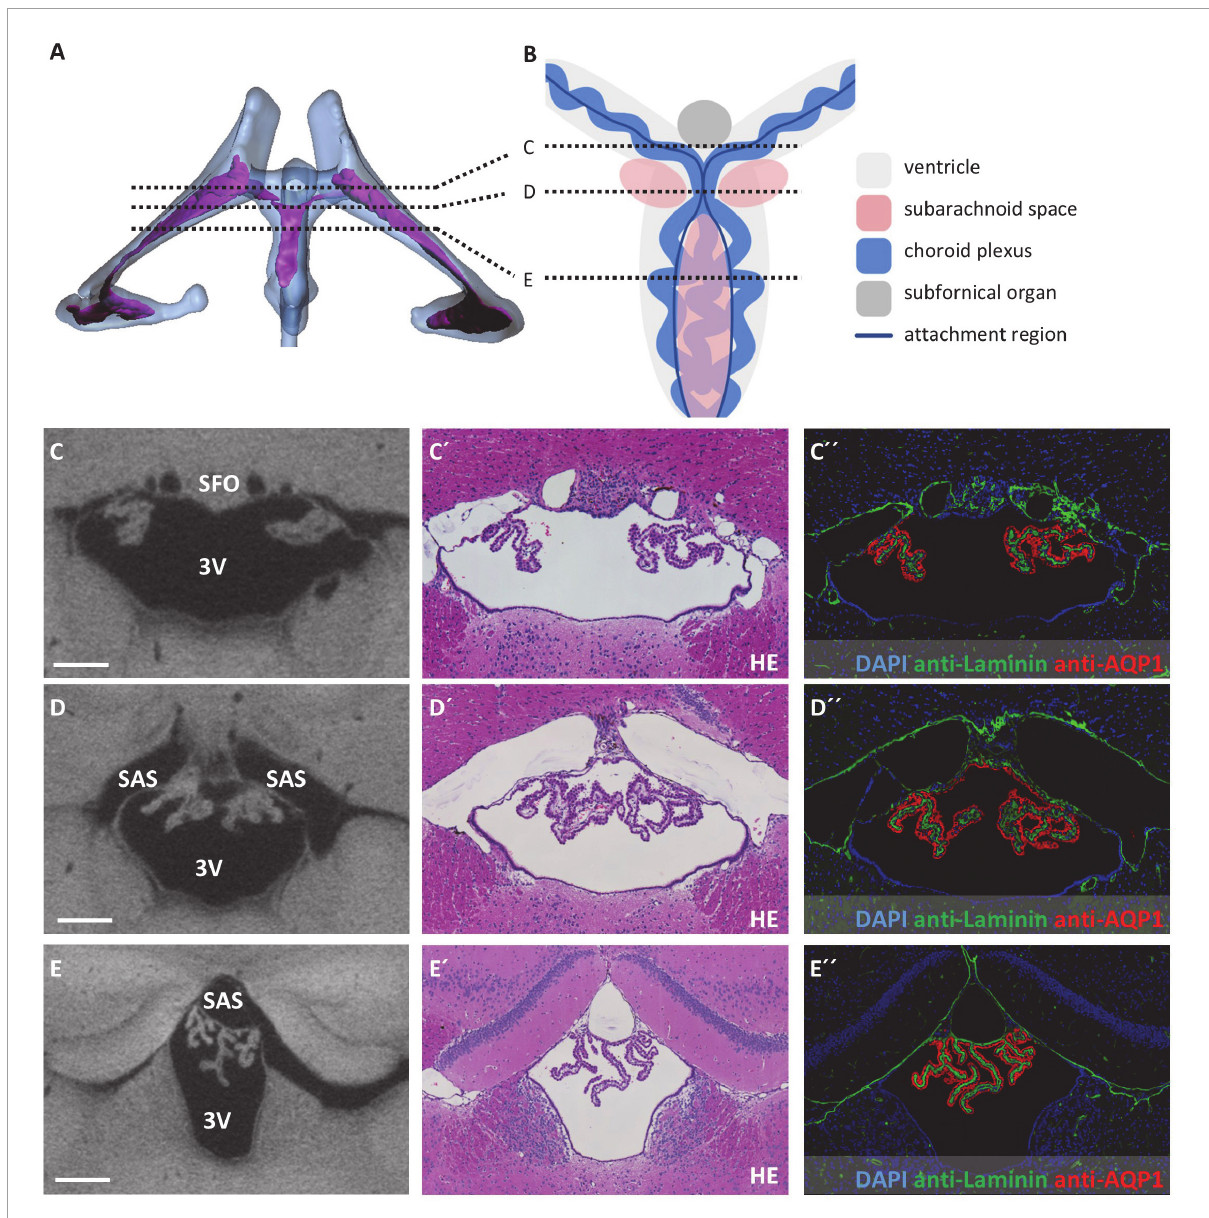
FIGURE4 Attachment regions of the choroid plexus in the third ventricle. (A) Illustration of sectional planes in three-dimensional reconstruction of the lateral and third ventricle (blue) and the choroid plexus (purple) in a dorsal view. (B) Schematic drawing of the third ventricle in dorsal view with choroid plexus, subfornical organ, subarachnoid space, and sectional planes of (C–E) . Created with BioRender.com (C–E) On the left, sectional planes from micro-computed tomography scan; in the middle, hematoxylin-eosin staining; and on the right, immunofluorescence double labeling with anti-laminin (green), anti-aquaporin1 (AQP1, red), and nuclear staining with 4 (cid:48) ,6-diamidino-2-phenylindole (DAPI, blue). (C–C”) Coronal section at the level of the subfornical organ occipital to the interventricular foramen; (D–D”) coronal section occipital to the subfornical organ with median attachment site of the choroid plexus and lateral cavities of subarachnoid space; (E–E”) coronal section at the level of the rostral hippocampus, the choroid plexus is attached to the roof of the third ventricle via two lateral attachments, the space between the two attachment sites belongs to the subarachnoid space. Scale bars in (C–E) 200 µ m. 3V, third ventricle; SAS, subarachnoid space; SFO, subfornical